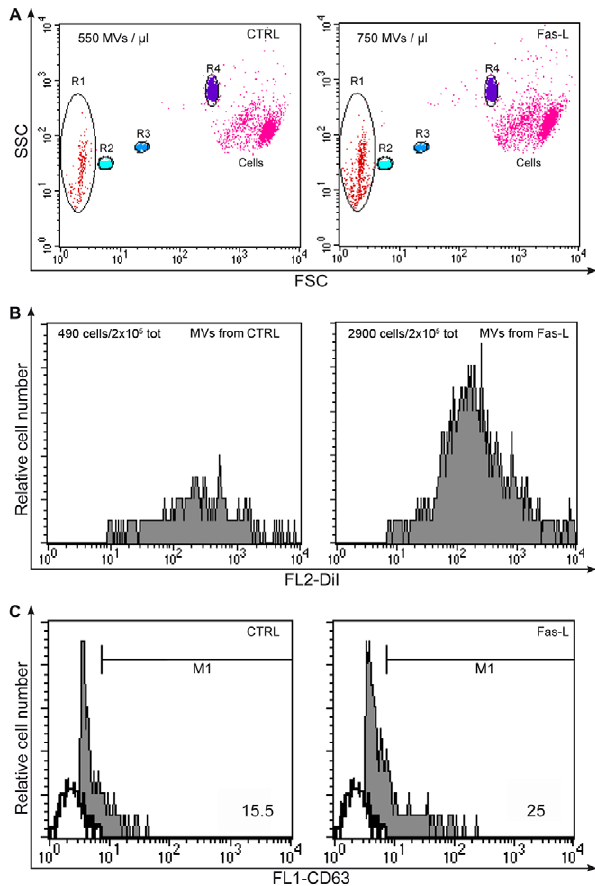
Figure 6. Flow cytometric analysis of FasL effects on MVs release. The release of MVs by CD4 + T cells with (Fas-L) and without (CTRL) FasL administration was evaluated using size beads, identified by R2 (1 m m), R3 (2 m m) and R4 (5,2 m m) regions (A). This gate strategy was performed to define the proper gate for events smaller than 1 m m (R1), which include MVs. FasL treatment performed for 1 h leads to an increase of events within R1 region, demonstrating an higher MVs presence in the medium. Histograms (B) show a higher number of DiI + events (gated on total cells) in CD4 + T cells after the addition of DiI + MVs released by FasL treated samples, attesting a major uptake in these ones if compared to acquired DiI + MVs from untreated control cells. (C), Shown are histograms of CD63-FITC staining on R1 gated MVs. CD63 expression (%) is derived from overlay of FL1 empty channel (white histograms) and CD63 filled channel (grey